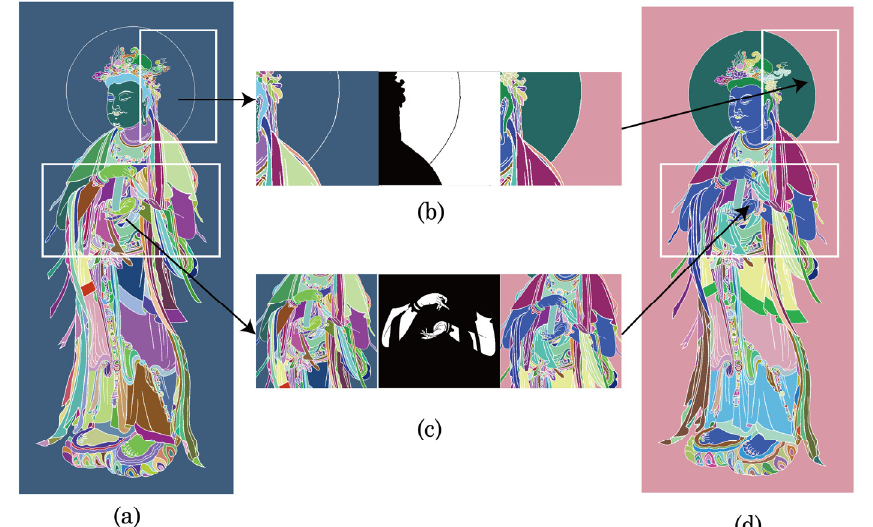
Figure 6. Segmentation result. (a) Original segmentation result; (b) Split baldachin region and background region; (c) Merge arms; (d) Optimized segmentation